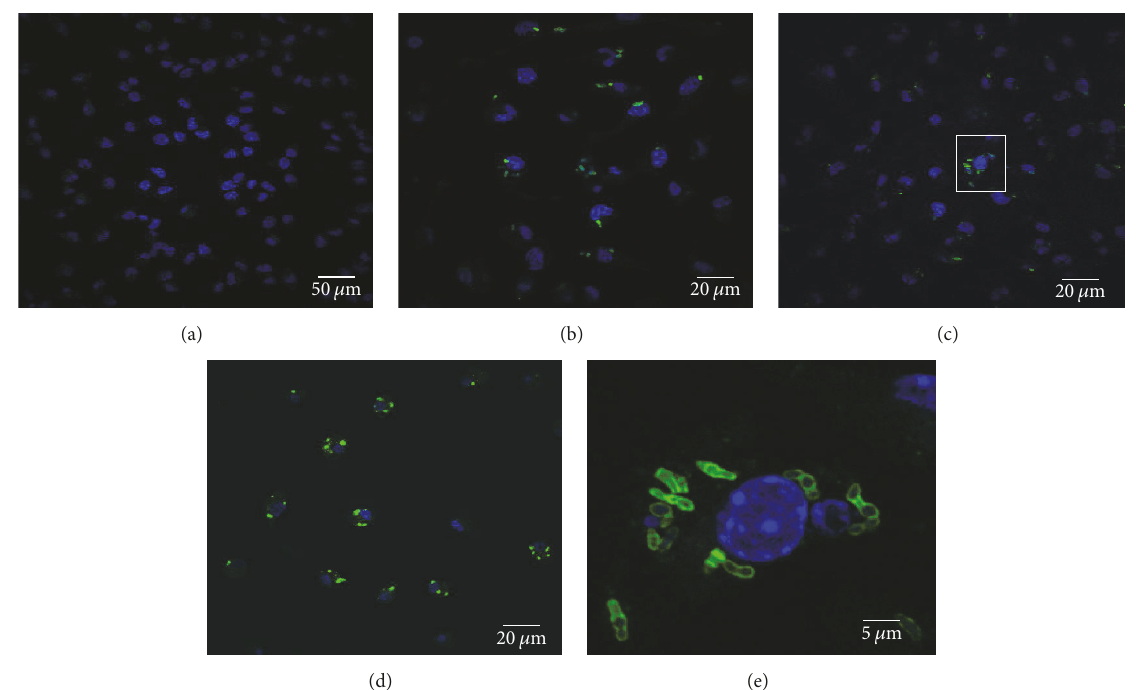
Figure 1: Internalization of R. equi in BMDM. Representative confocal immunofluorescence images showing intracellular localization of R. equi in BMDM at various time points after infection: (a) uninfected, (b) 12h, (c) 24 h, (d) 48 h, and (e) 240x magnification of the inset from image (c). R. equi are labeled green with rabbit polyclonal R. equi antibodies and the nuclei are labeled blue with DAPI. Increasing bacterial load is observed in infected BMDM at later times after infection. Pictures are representative of results obtained from three independent